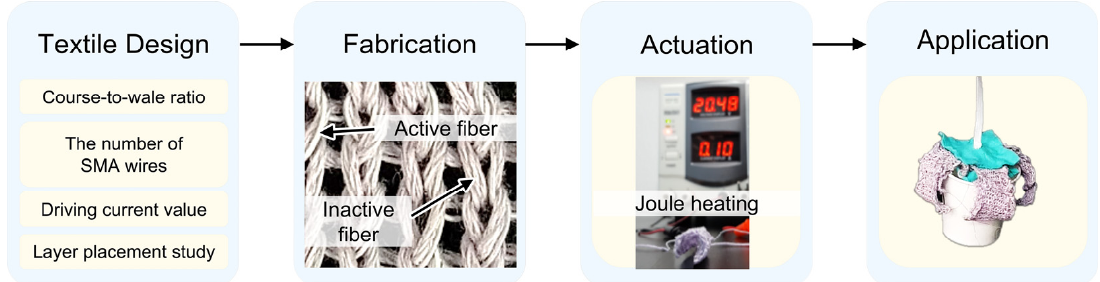
Figure 1. Methodology flow chart illustrating the major milestones of this work.